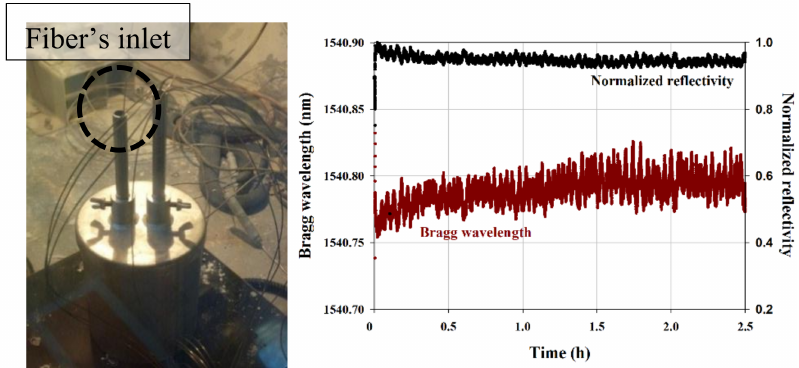
Figure 13. Sodium box installed in the Penelope facility and heated from the bottom ( left ). The fiber’s inlet is highlighted: a single capillary is enough to position 5 multiplexed regenerated FBGs; the other inlet is for three thermocouples. On the right, stability of a regenerated FBG in hot sodium (500 ◦